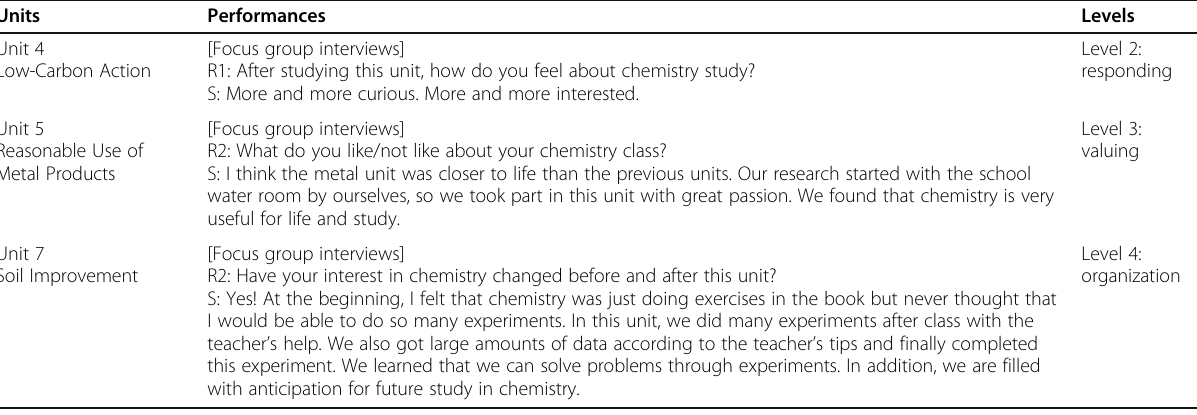
Table 7 Students ’ performances in motivation to learn chemistry Units Unit 4 Low-Carbon